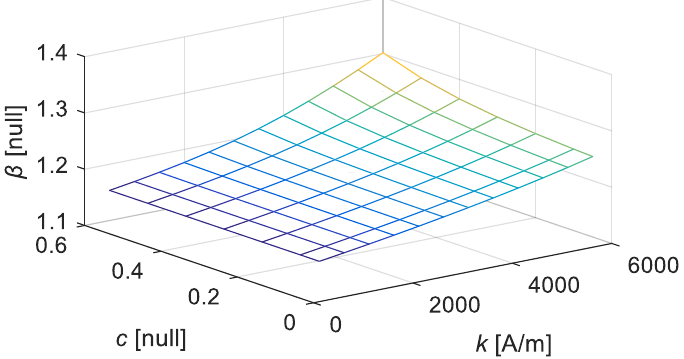
Figure 13. Estimates of β under different values of k and c ( a = 12 kA/m, α = − 0.001, M S = 80 kA/m).